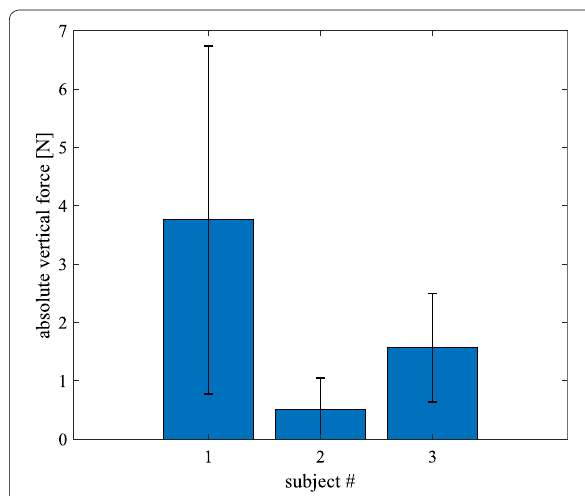
Fig. 16 Absolute vertical force of the subjects applied to the robot handle during walking. The plots show the absolute vertical force | f z | applied to the cane robot by the subjects walking on the treadmill. Before the experiments, the subjects were instructed to touch the robot